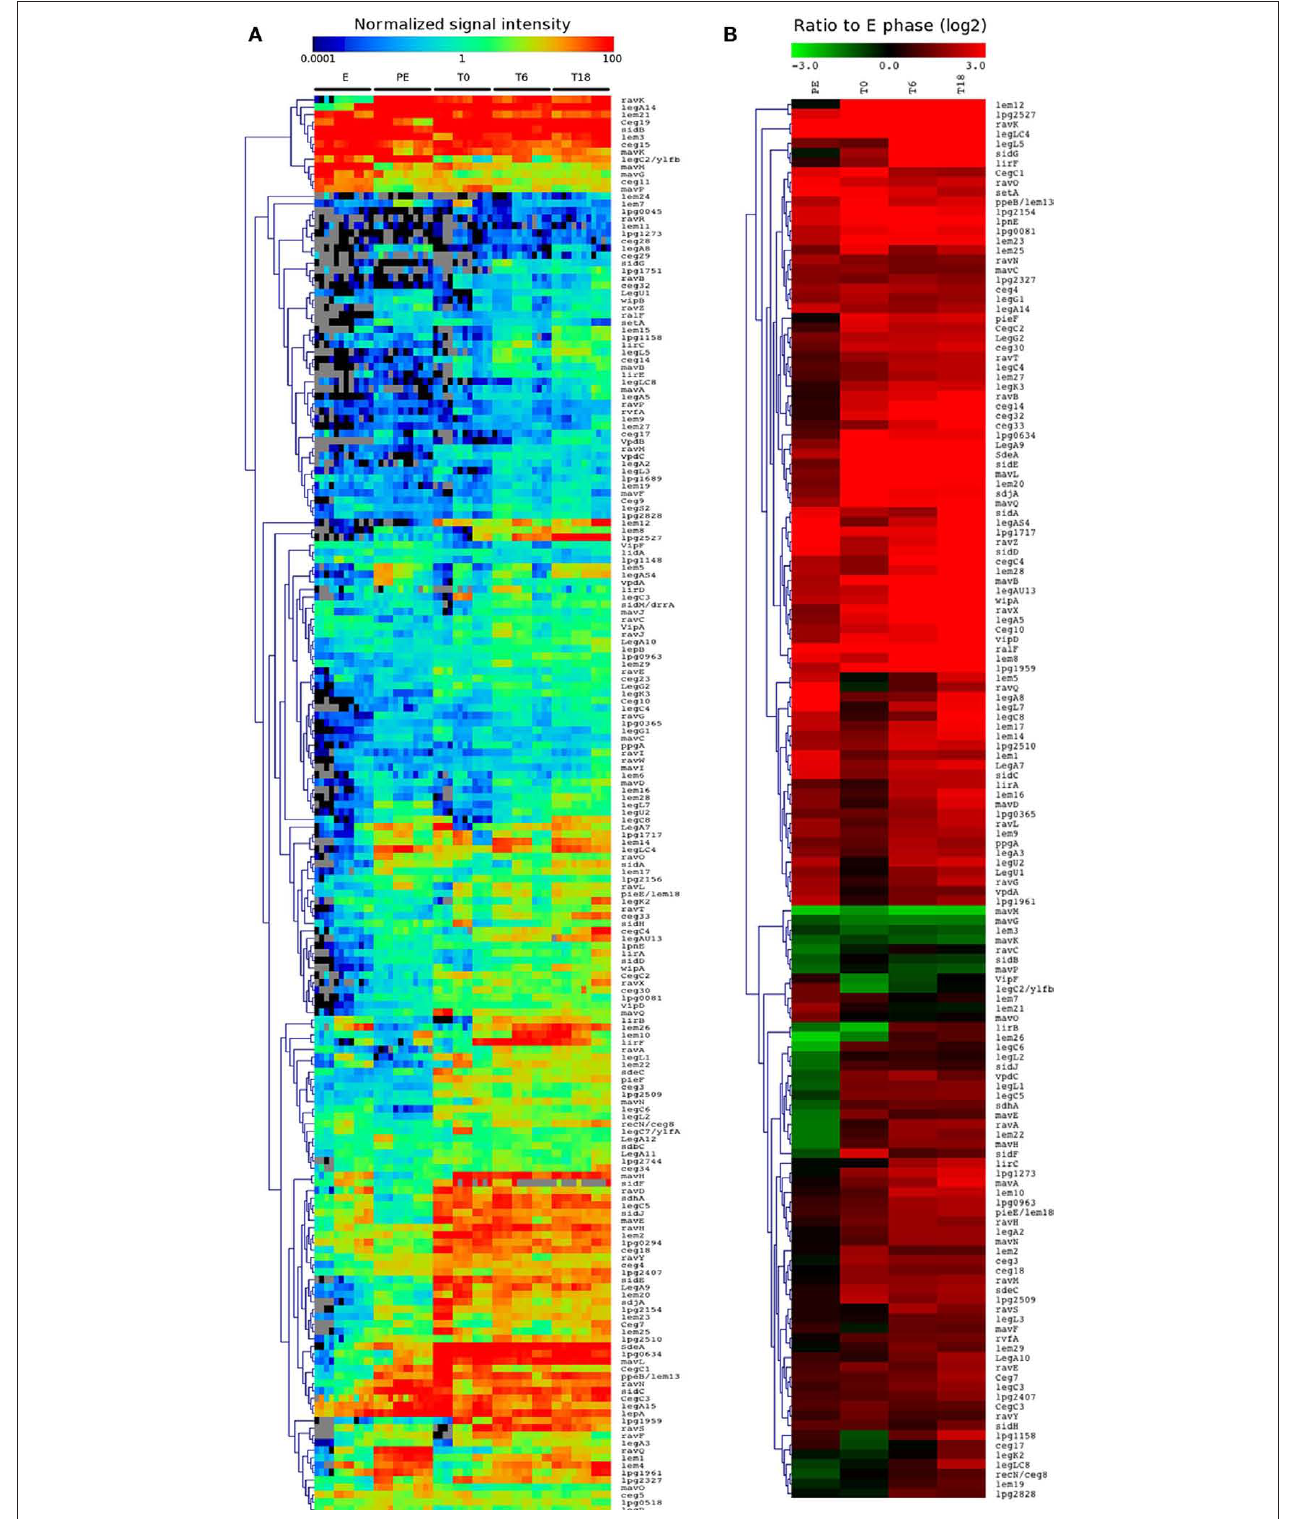
FIgURe 8 | Icm/Dot effectors are differentially expressed inside human cells. (a) Hierarchical clustering of the normalized signal intensity of the genes encoding Icm/Dot effectors for each replicate and each condition.